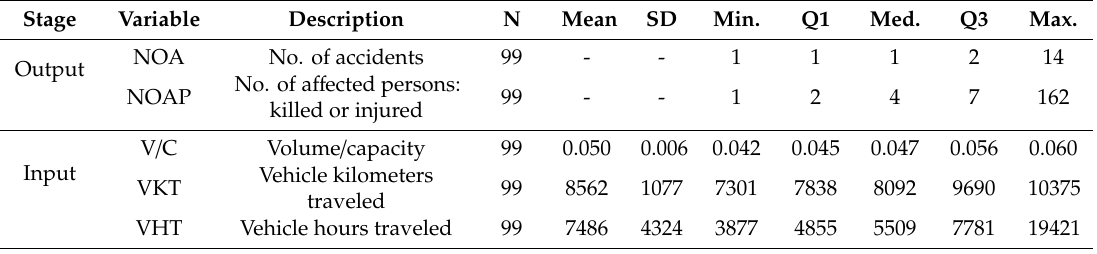
Table 1. Description for road accident data